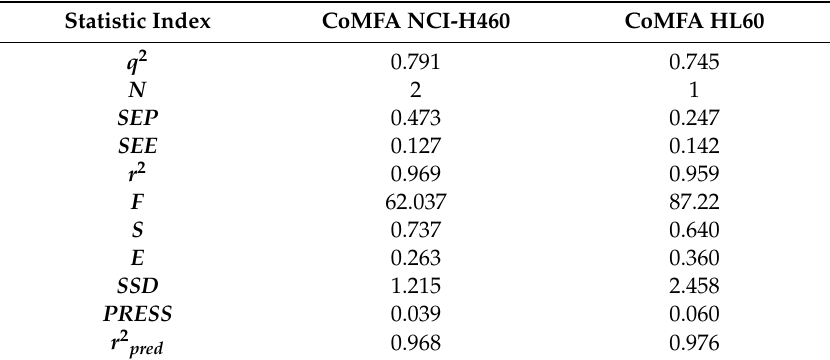
Table 4. Statistical parameters of the CoMFA models a